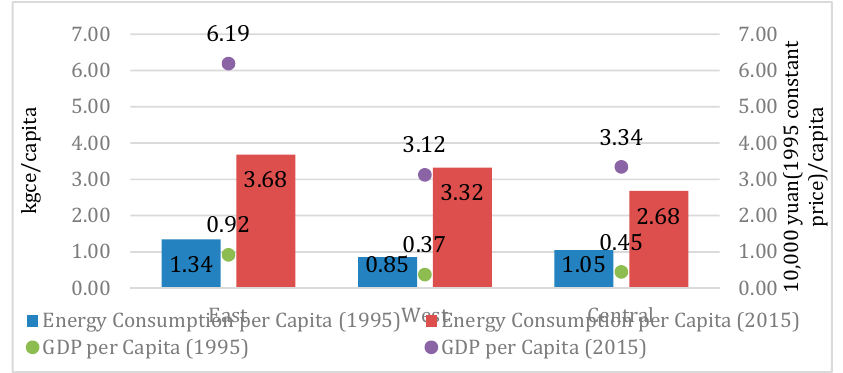
Figure 2. Energy consumption and gross domestic product (GDP) per capita in 1995 and 2015 by region.